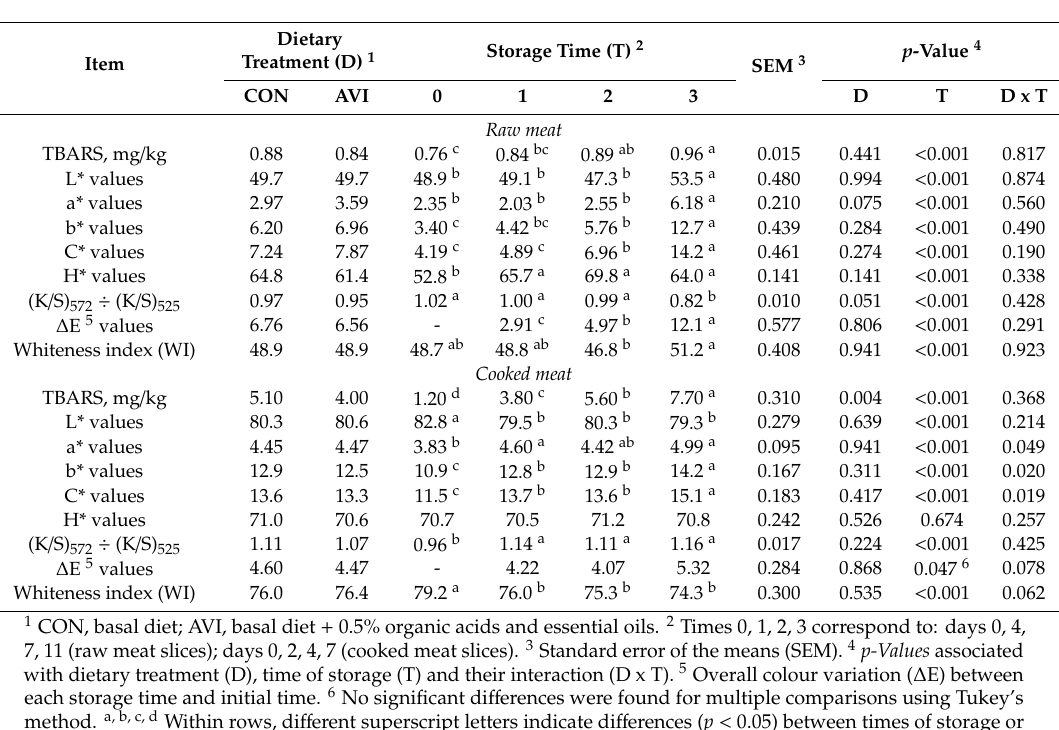
Table 5. E ff ect of the dietary treatments and time of storage on the oxidative stability of raw and cooked meat.